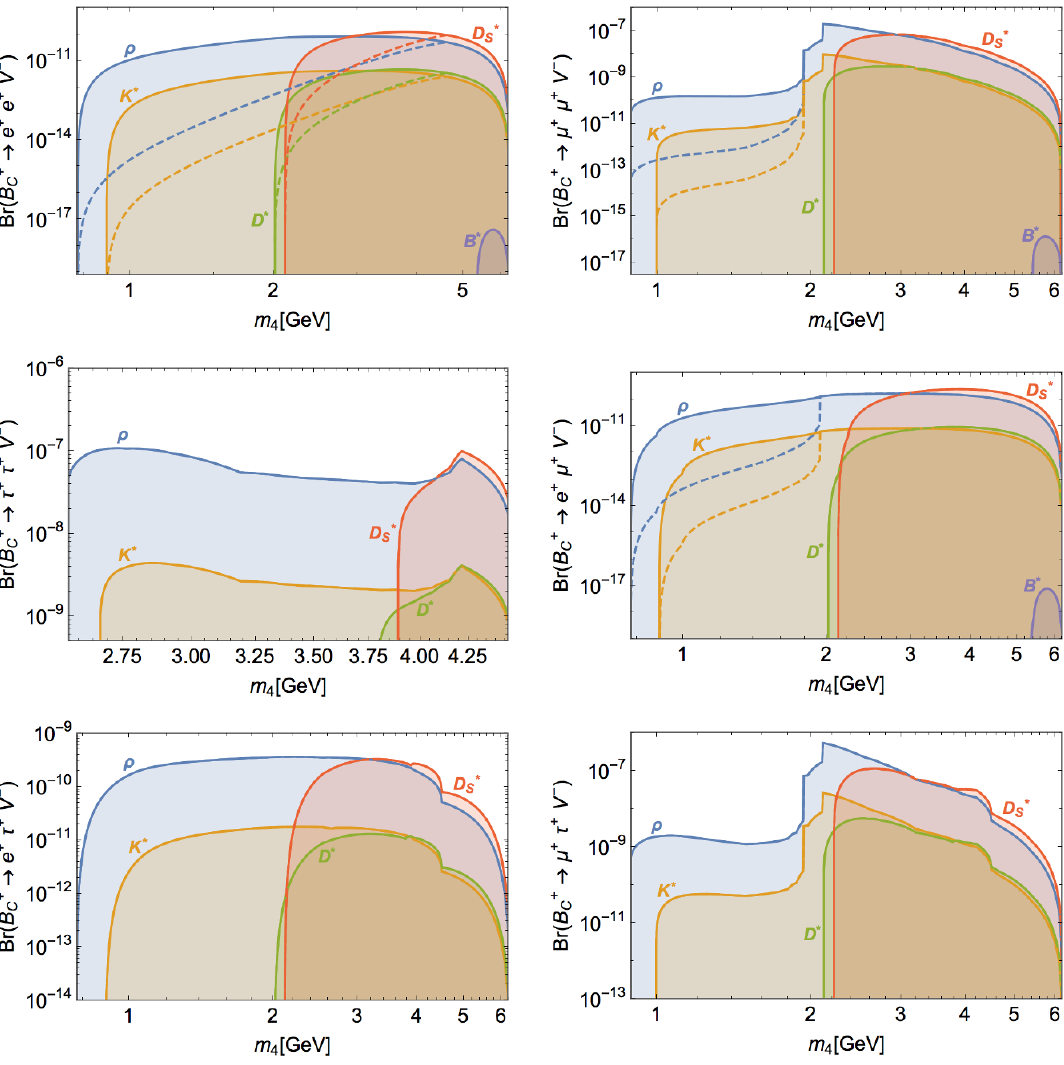
Figure 11 . Branching ratios of LNV decay modes of B + mesons (into vector (cid:12)nal states, plus c leptons of same or di(cid:11)erent (cid:13)avour), as a function of the (mostly sterile) heavy neutrino mass, m 4 . Pale blue, yellow, red, green and blue curves (surfaces) respectively denote the maximal (allowed) values of the BR( B + ! ‘ (cid:11) ‘ (cid:12) V (cid:0) ), with V (cid:0) = (cid:26) , K (cid:3) , D (cid:3) , D (cid:3) and B (cid:3) ; coloured dashed curves c s denote the corresponding maximal values of the BRs once c(cid:28) 4 (cid:20) 10 m is